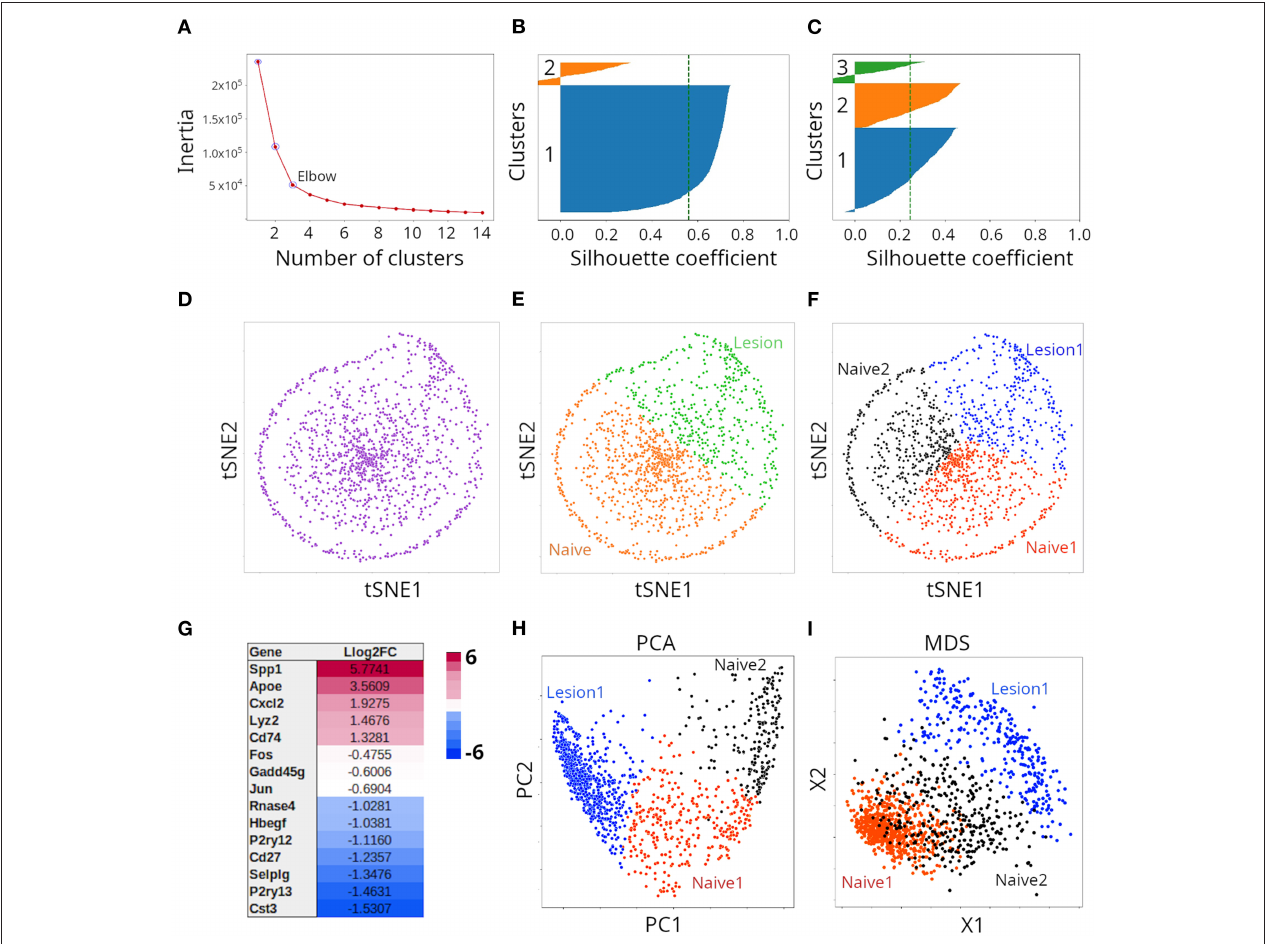
FIGURE 5 | Clustering of microglia single cell transcriptomes using tSNE, PCA or MDS. (A) Determination of optimal number of clusters through K-means clustering. Validation of cluster number (n) with the Silhouette method when two (B) or three (C) clusters were considered. (D) Transcriptome samples clustered with tSNE ( n = 2) and colored with a single color, or with two colors (E) . Such clusters correspond to naive and lesion cells. (F) Transcriptome samples clustered with tSNE ( n = 3) and colored with three colors. Such clusters correspond to two naive and one lesion groups of cells. (G) Representative differentially expressed genes between naive and lesion cells (see E ), were in agreement with ( 8). (H) Transcriptome samples clustered by PCA or with MDS (I)